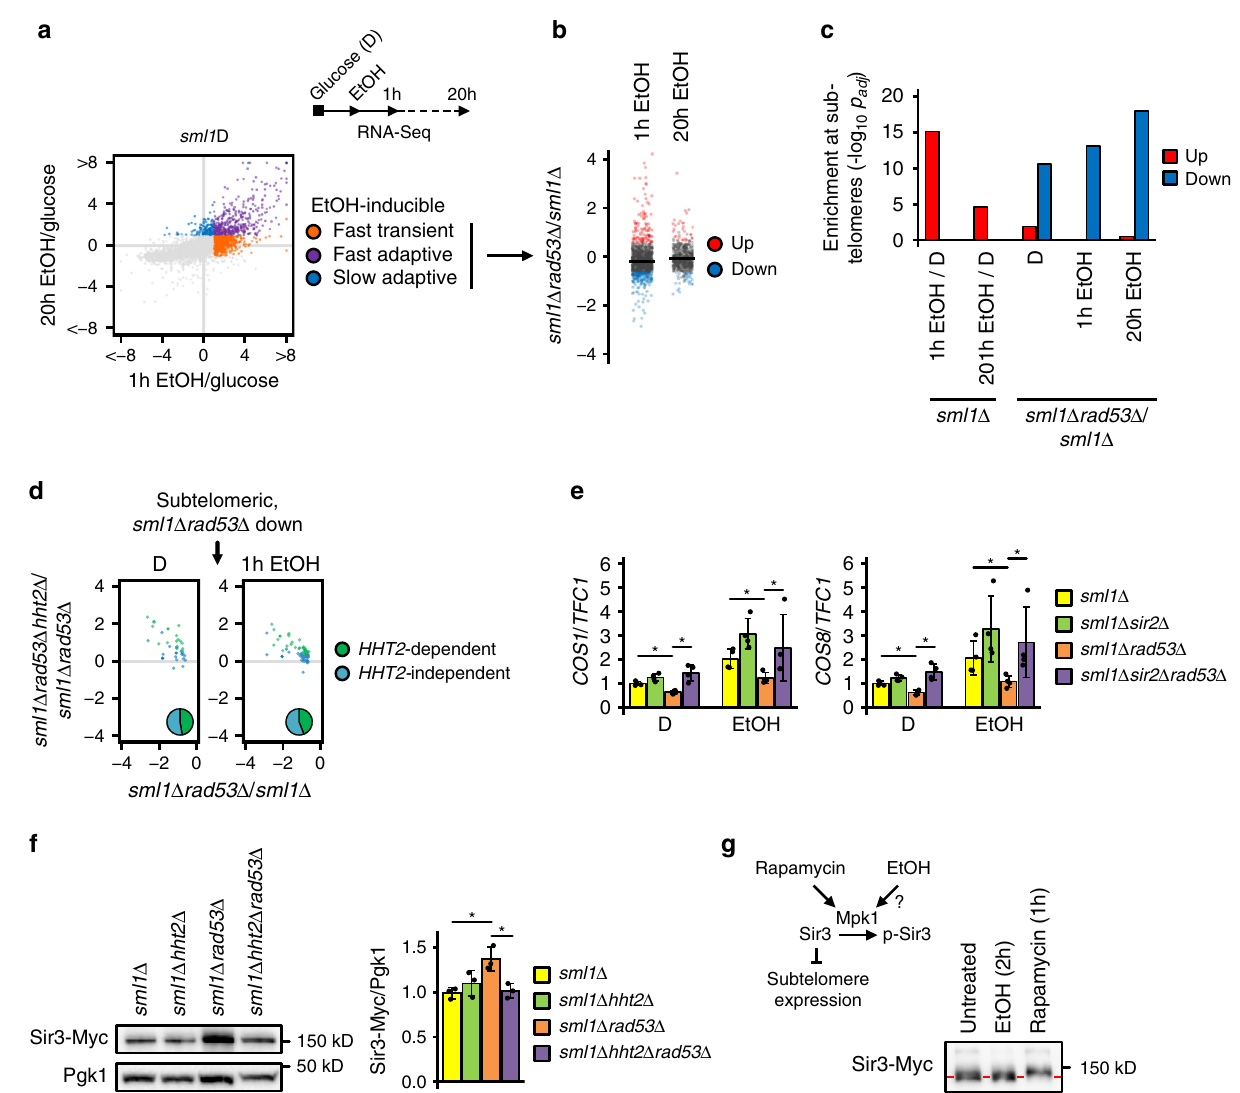
Fig. 2 Excess histones suppress a subtelomeric starvation response. a RNA-Seq analysis of carbon source switch in synthetic complete medium. EtOH- inducible genes were categorized as transient or fast/slow adaptive based on their expression at 1 h or 20 h after switching sml1 Δ cells from glucose to ethanol. b Expression fold changes (log2) of switch-induced genes in sml1 Δ rad53 Δ vs sml1 Δ cells at 1 h or 20 h after carbon source switch. Each dot represents one gene. c Enrichment analysis by hypergeometric test of genes in telomere proximity that are up- or downregulated by carbon source switch (EtOH/D) in sml1 Δ cells, or by deletion of RAD53 ( sml1 Δ rad53 Δ / sml1 Δ ). d Expression fold changes (log2) of subtelomeric repressed genes in sml1 Δ rad53 Δ hht2 Δ vs. sml1 Δ rad53 Δ cells. Each dot represents one gene. e RT-qPCR expression analysis of COS1 and COS8 genes in the indicated genotypes in glucose and 90 min after ethanol switch. TFC1 was used as normalization control. ( n = 4 replicate cultures). Signi fi cances were calculated by Kruskal – Wallis rank sum test ( p D_ COS1 = 0.0097, p EtOH_ COS1 = 0.013, p D_ COS8 = 0.0045, p EtOH_ COS8 = 0.013), followed by Mann – Whitney test (two-sided) with Benjamini – Hochberg correction ( p D_ COS1 _ sml1 Δ rad53 Δ _vs_ sml1 Δ = 0.029, p D_ COS1 _ sml1 Δ rad53 Δ sir2 Δ _vs_ sml1 Δ rad53 Δ = 0.029, p EtOH_ COS1 _ sml1 Δ rad53 Δ _vs_ sml1 Δ = 0.029, p = 0.029, p = 0.029, p = 0.029, p = EtOH_ COS1 _ sml1 Δ rad53 Δ sir2 Δ _vs_ sml1 Δ rad53 Δ D_ COS8 _ sml1 Δ rad53 Δ _vs_ sml1 Δ D_ COS8 _ sml1 Δ rad53 Δ sir2 Δ _vs_ sml1 Δ rad53 Δ EtOH_ COS8 _ sml1 Δ rad53 Δ _vs_ sml1 Δ 0.029, p loading control Pgk1. Signi fi cances were calculated with one-way ANOVA ( p = 0.0104) with post hoc Tukey HSD test ( p sml1 Δ rad53 Δ _vs_ sml1 Δ = 0.012, = 0.018). n = 3 independent experiments. g sml1 Δ cells expressing endogenous 13xMyc-tagged Sir3 were cultured in normal p sml1 Δ rad53 Δ hht2 Δ _vs_ sml1 Δ rad53 Δ glucose and subjected to either 2 h glucose-to-ethanol switch or 1 h rapamycin treatment. Sir3 bandshift re fl ecting phosphorylation was analyzed by western blot. The red dashed line indicates un-phosphorylated Sir3. The scheme summarizes the Mpk1-Sir3 pathway. Bars plots with error bars represent mean values and standard deviation, D glucose; EtOH ethanol. * p <